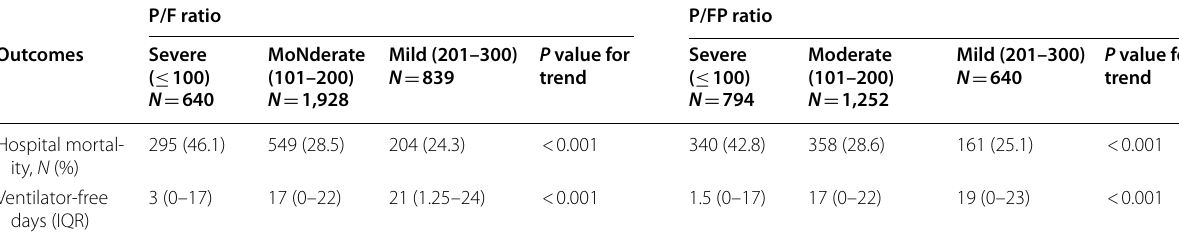
P values refer to comparisons of hospital mortality and ventilator-free days between patients classified as having severe, moderate, and mild ARDS. IQR interquartile range, P/F ratio of the PaO 2 to FiO 2 ; P/FP (PaO 2 * 10)/(FiO 2 * = =